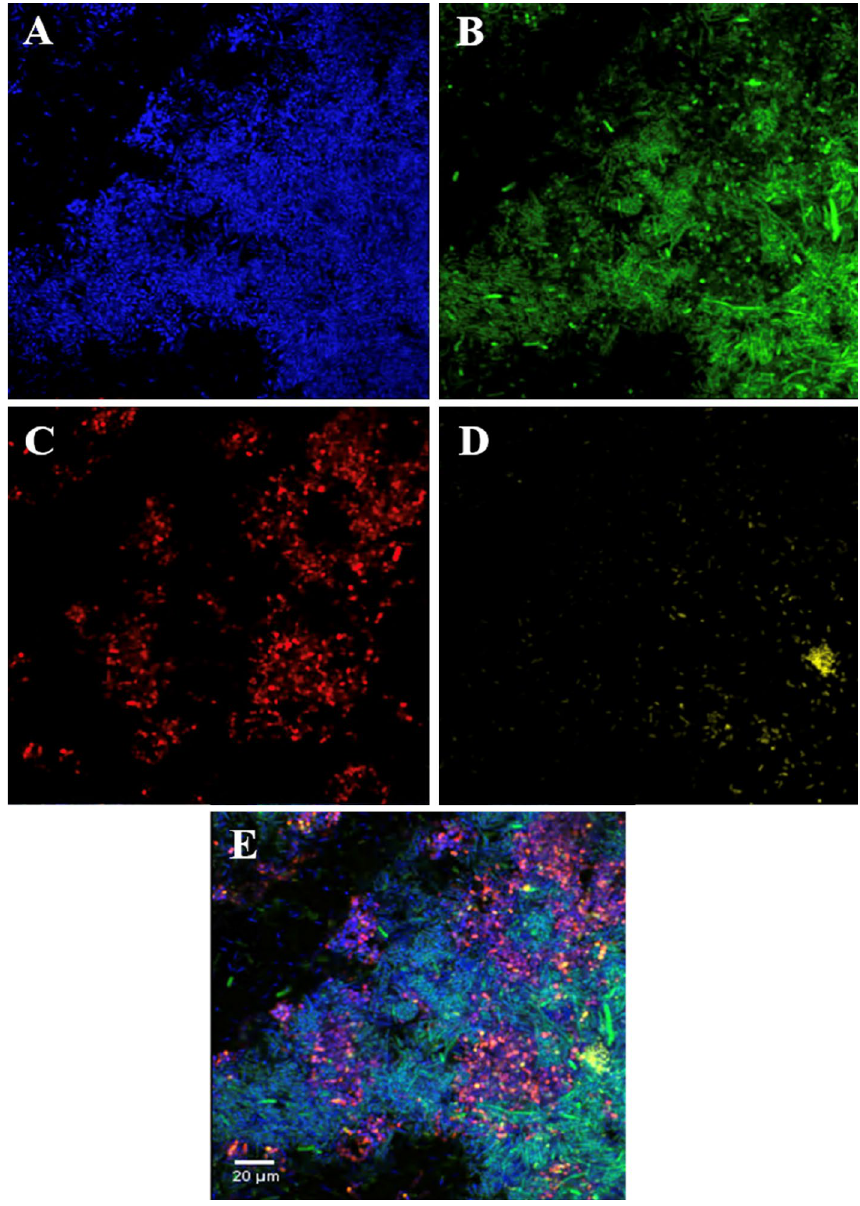
Figure 3. Fluorescence in situ hybridisation staining of Streptococcus pyogenes ATCC 700,294, Pseudomonas aeruginosa ATCC BAA-47 and Escherichia coli K-12 DH5 alpha, ATCC PTA-4079 mixed cells from broth culture. ( A ) Nucleic material/DAPI in blue, ( B ) Eubacterial probe (EUB) in green, ( C ) Streptococcus spp . specific probe (STRC493) in red, ( D ) Pseudomonas spp . specific probe (PSE227) in yellow, ( E ) composite image of ( A – D ). Images at ×60